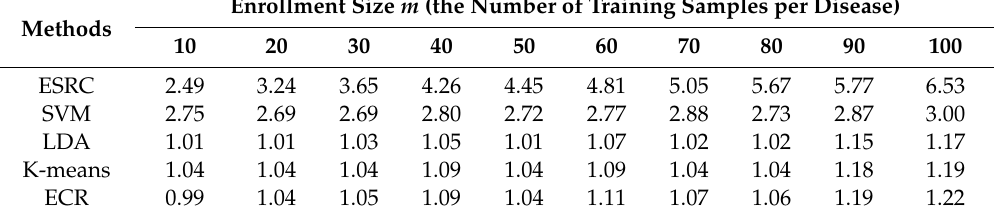
Table 7. The average online diagnostic time (ms) of each query sample with respect to di ff erent recognition